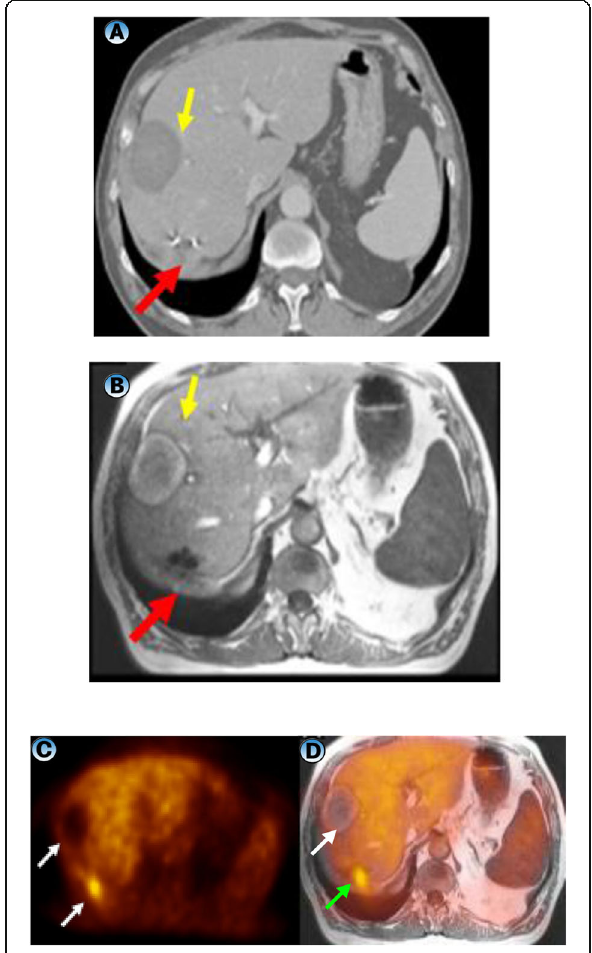
Fig. 2 A 54-year-old male patient with history of sigmoid carcinoma treated surgically, followed by partial segmentectomy and RFA of hepatic metastatic lesions. On routine follow up the patient showed elevated CEA level. a Axial post contrast CT image of the liver showed well-defined hypodense area of coagulative necrosis (yellow arrow) with no evidence of pathological enhancement along its vicinity; Metallic sutures at the segmentectomy site distorting the image quality (red arrow) with no evidence of surrounding pathological enhancement could be detected as well. b Axial post contrast MRI image of the liver showed well-defined high T1 signal area of coagulative necrosis with no evidence of pathological enhancement along its vicinity (yellow arrow), metallic susceptibility artifact of the metallic sutures at the segmentectomy site distorting the image quality (red arrow) with no evidence of surrounding pathological enhancement could be detected. c Axial PET image of the liver and d axial fused PET/MRI image of the liver revealed FDG uptake with SUVmax 6 at the segmentectomy bed (green arrows) (proved to be metastatic activity) and no uptake at the ablated lesion (white arrows)